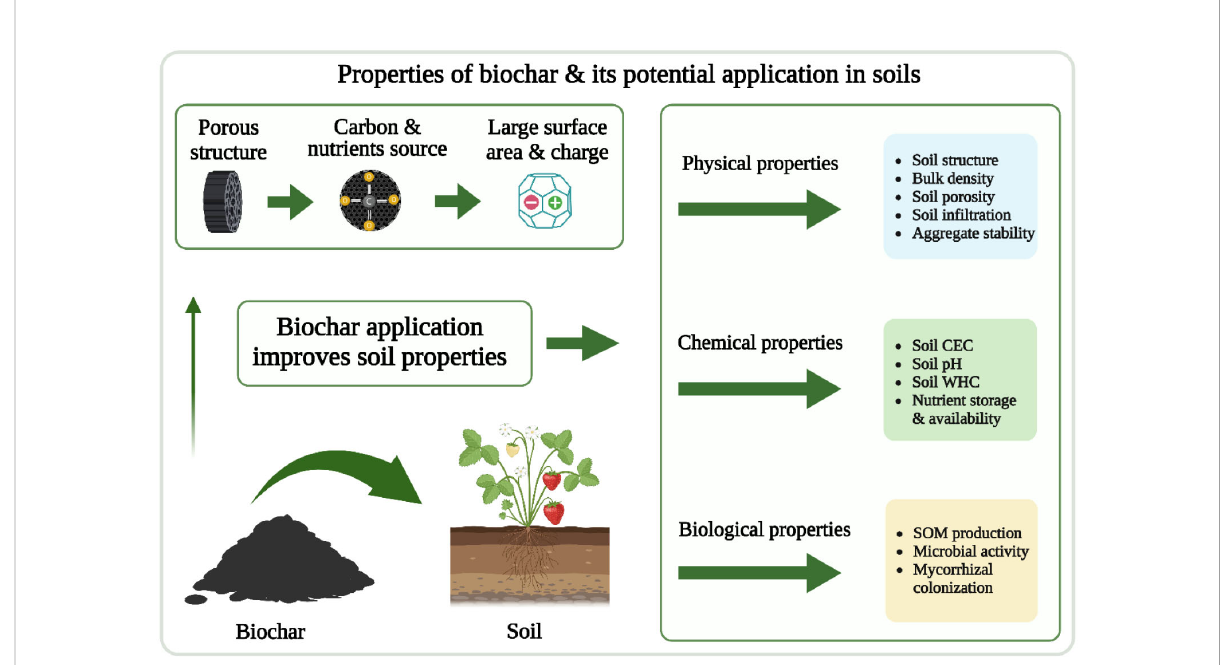
FIGURE 4 A visual demonstration of biochar impacts on soil